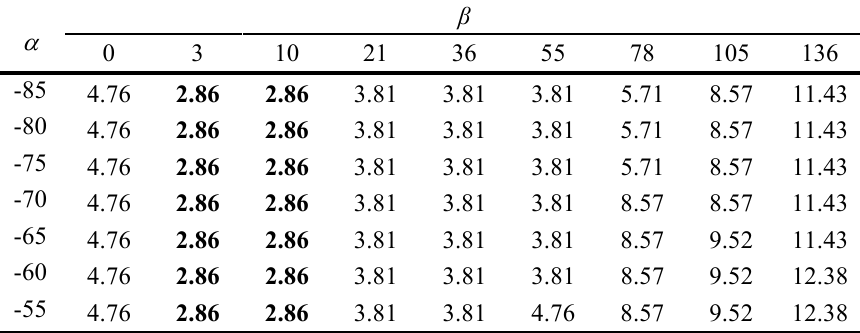
Table 1(b). Variation in percentage error rate for some values of α and β for NTIPS = 4 on Yale face